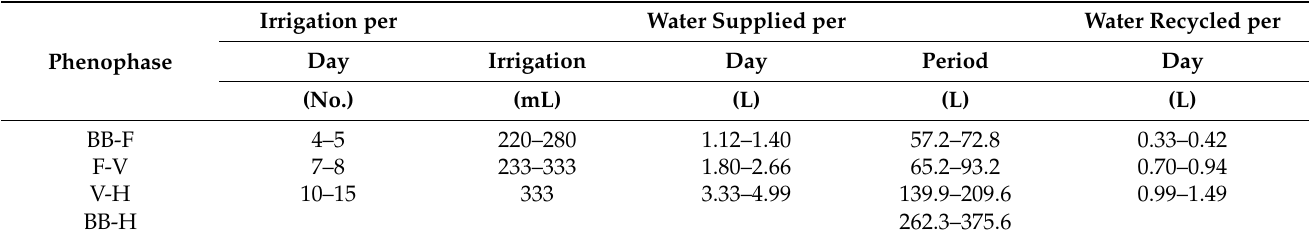
Table 12. Amount (min.–max.) of nutrients supplied per period and per plant z .